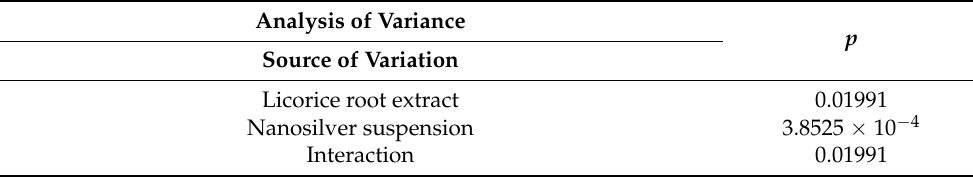
Table 3. Results of the statistical analysis of hydrogels’ tensile strength measurements performed via the two-way analysis of variance (ANOVA) ( p indicates the statistical significance).